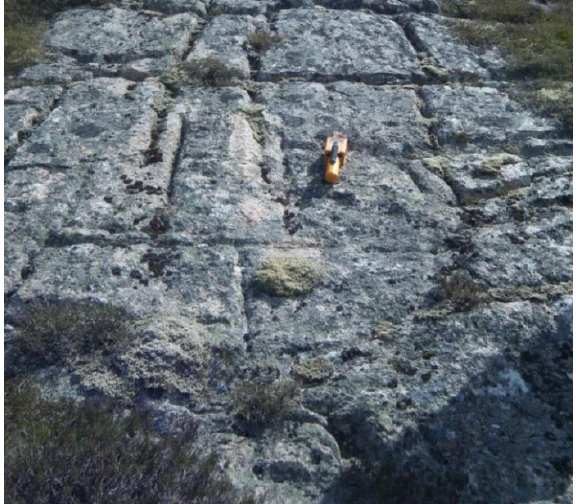
Figure 7. An example of where the largest section of intact granite was chosen to place the gamma surveyor II (GSII), away from the perpendicular fractures. For scale, the GSII is 28 cm long and 9 cm